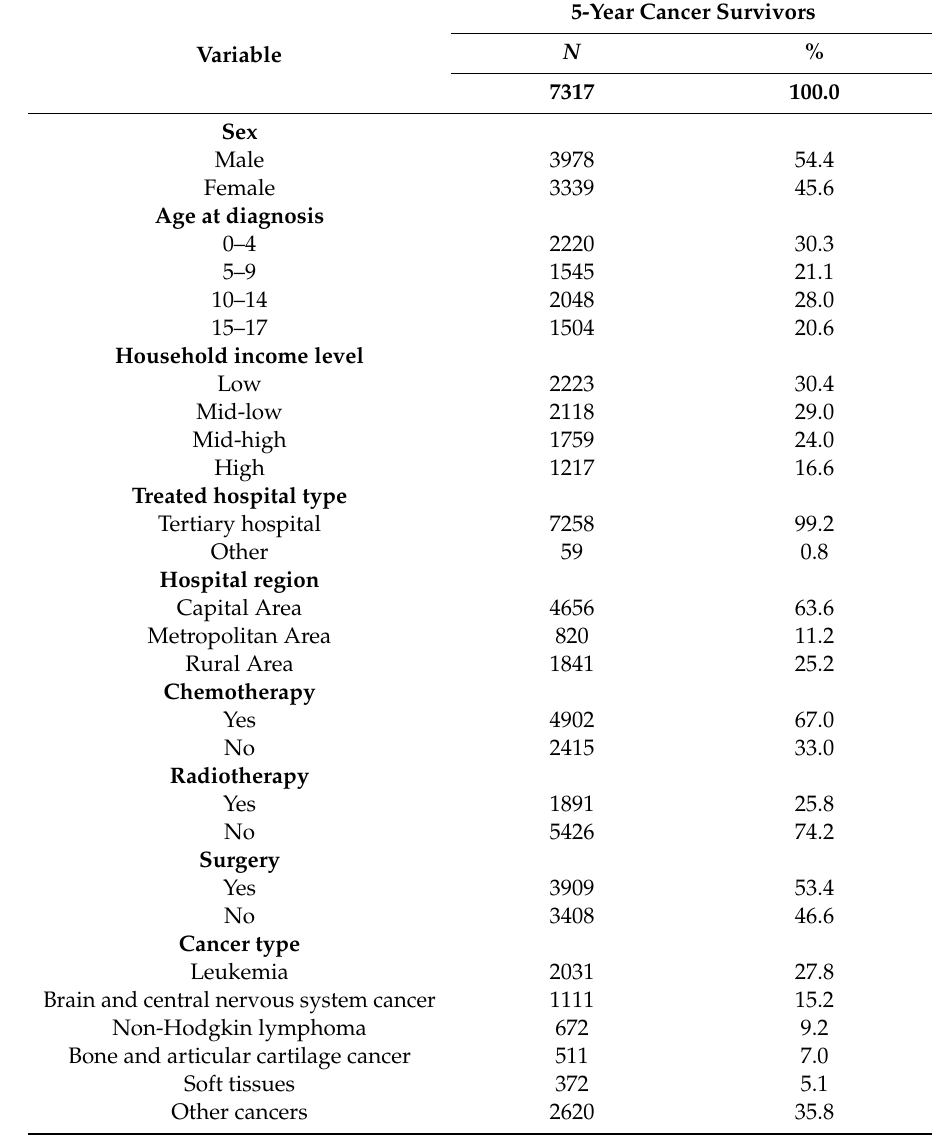
Table 1. General characteristics of the study